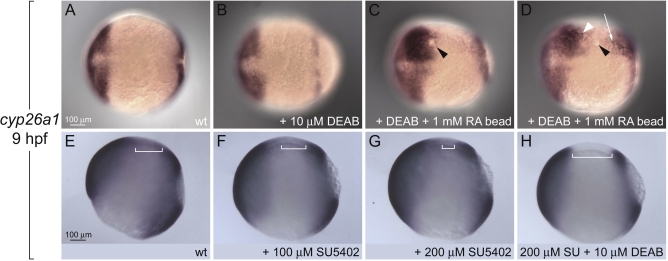
Regulation of cyp26a1 by RA and Fgfs(A and B) Anterior and marginal expression domains of cyp26a1 expression are unchanged by 10 μM DEAB. Anterior is to the left in all panels.(C and D) RA beads (black arrowheads) induce cyp26a1 expression in DEAB-treated embryos far from (white arrowhead and arrow in [D]), but not adjacent to the bead.(E–H) Fgf signaling sets the posterior boundary of cyp26a1 expression.(E) cyp26a1 expression in wild type (wt) (lateral view, anterior to the left).(F and G) Expression in SU5402-treated embryos shifts posteriorly in a concentration-dependent manner (compare brackets in [E], [F] and [G]).(H) The posterior shift caused by blocking Fgf signaling is abolished by DEAB treatment.